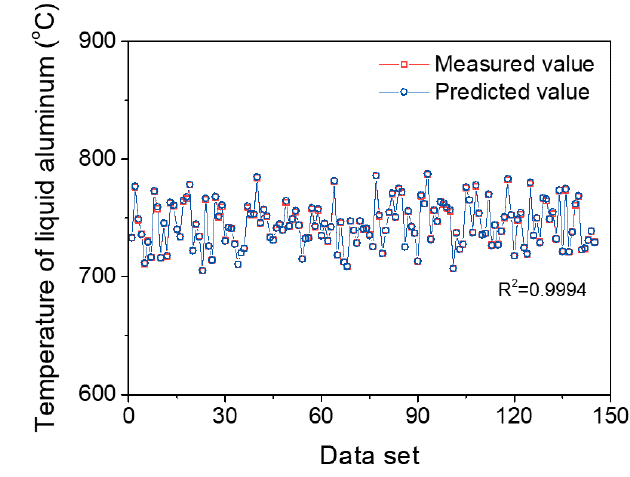
Figure 5. The comparison between measured values by experiment versus predicted values by linear